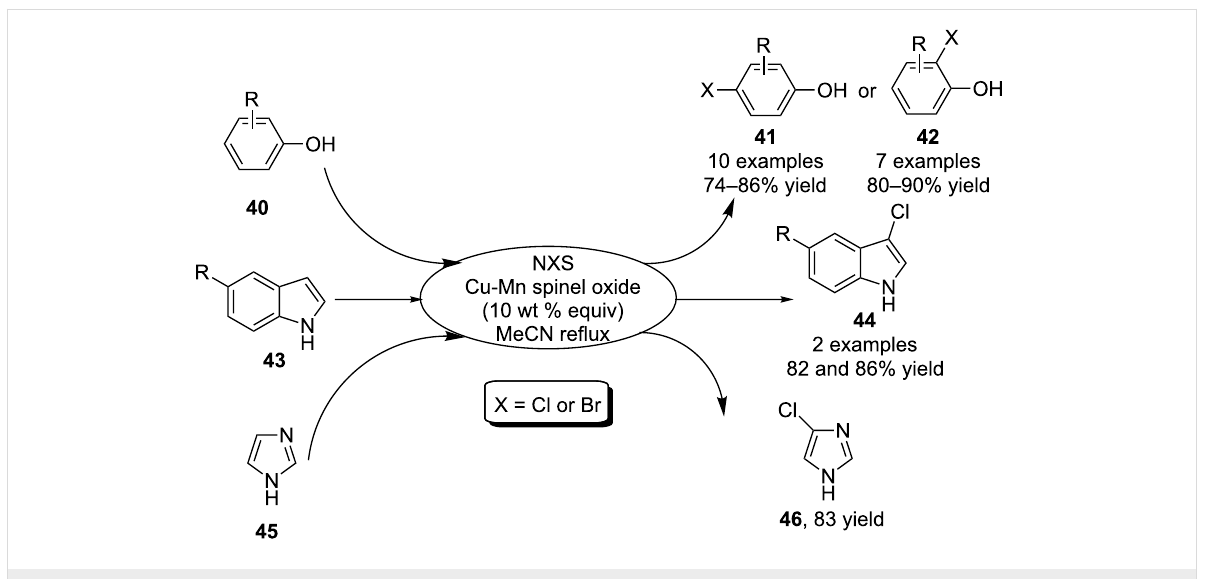
Scheme 16: Cu-Mn spinel oxide-catalyzed phenol and heteroarene halogenation.